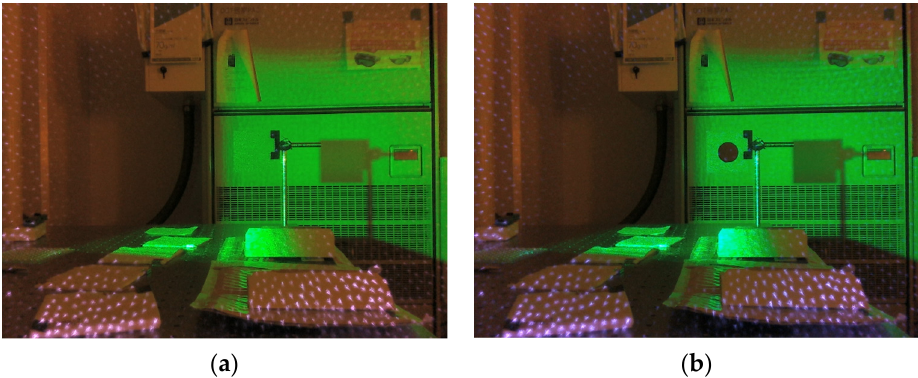
Figure 4. Examples of acquired raw data (P0, Acc = 1, Exp: 10,000 µ sec, image size 640 × 480 px): ( a ) Raw data with frost glass sample; ( b ) Raw data with Si sample.